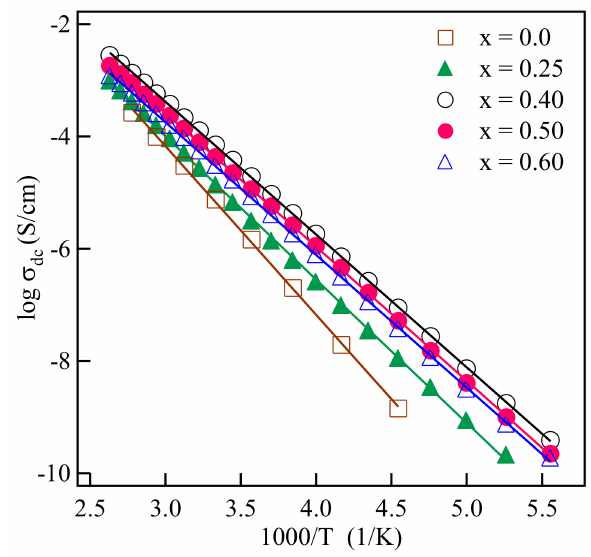
Figure 3. The temperature dependence of the total ionic conductivity for different compositions of Li 5+2x La 3 Nb 2 − x Sm x O 12